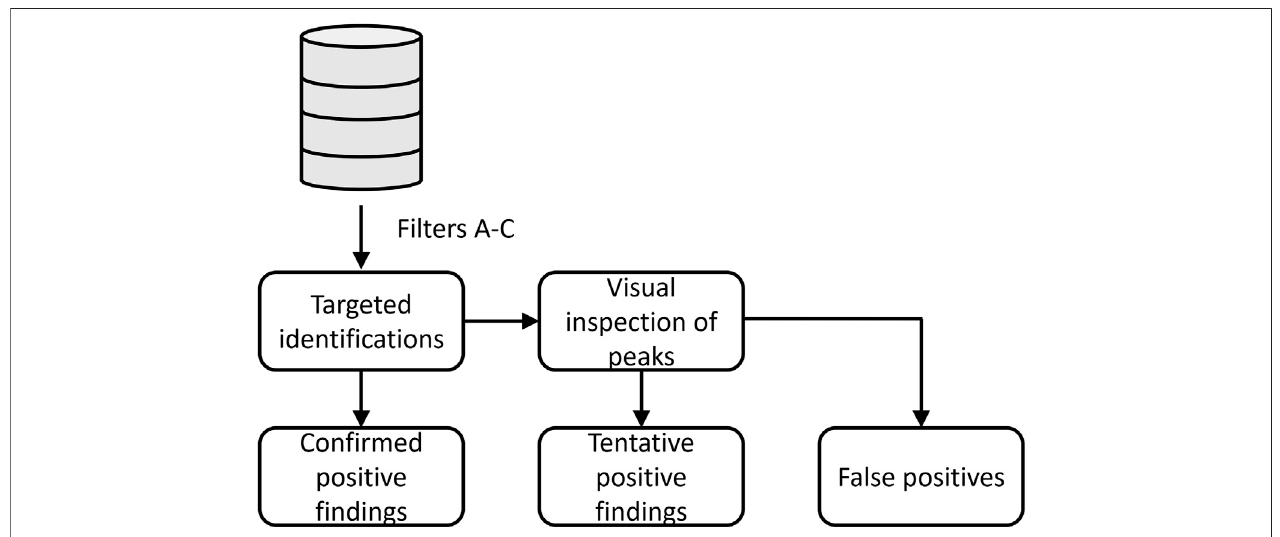
FIGURE3| Trainingsethitsforprecursorionm 0 inthemass (A,B) andretentiontime (C,D) domaincomparedwithlibraryvalues,plottedagainstm 0 intheintensity (cid:129) count domain. Hits from samples with positive quantitative results (A,C) ;